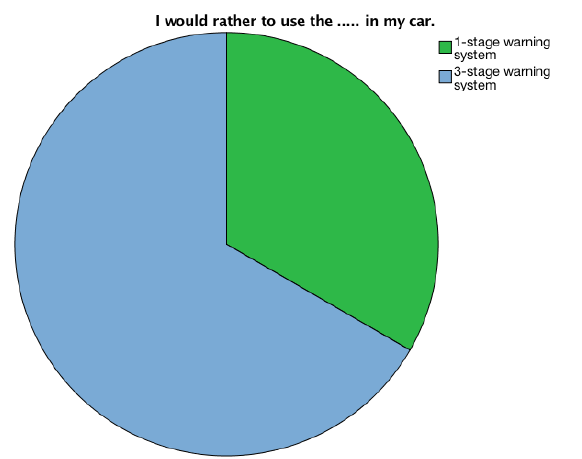
Figure 9. Final decision